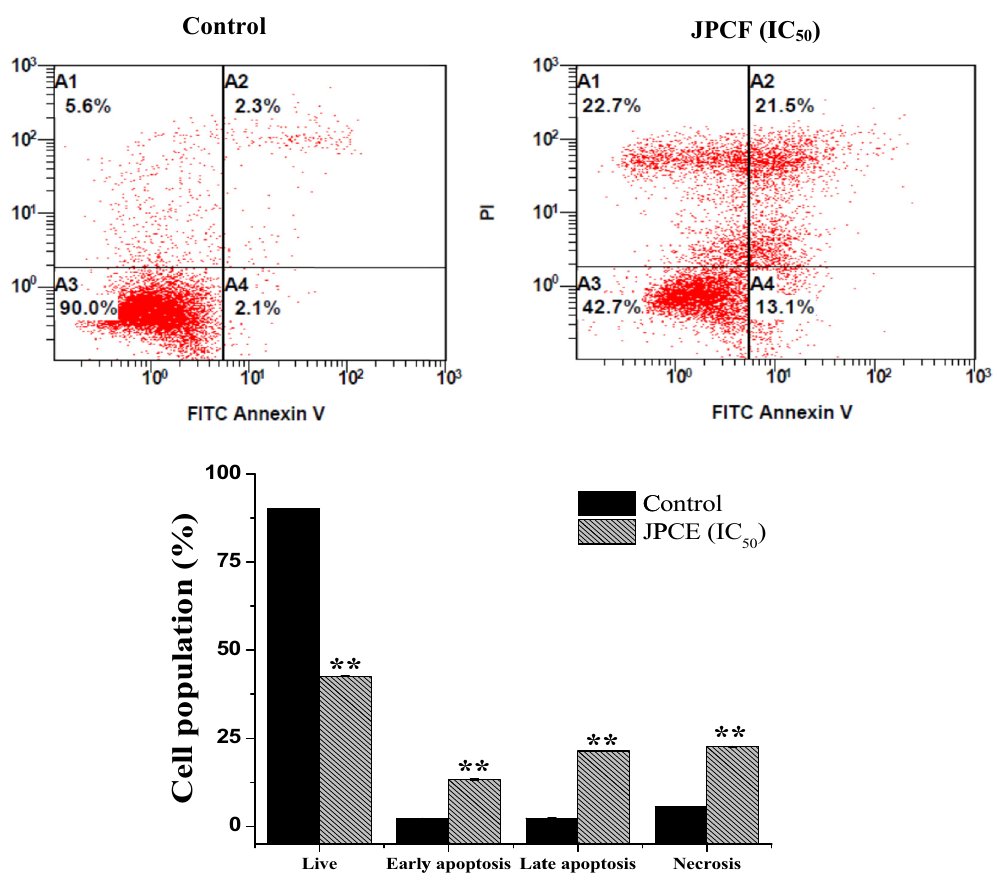
Figure 3: Induction of apoptosis and necrosis in MCF - 7 cells by J. phoenicea chloroform fraction. MCF - 7 cells were treated with the test fraction at IC 50 for 24 h, then stained with FITC - Annexin V/PI. Dot Plots of JPCF - treated and untreated MCF - 7 cells obtained using fl ow cytometer where a1 = necrosis, a2 = late apoptosis, a3 = viable, and a4 = early apoptosis. The percentage ( % ) of cell distribution. * p ≤ 0.05, ** p ≤